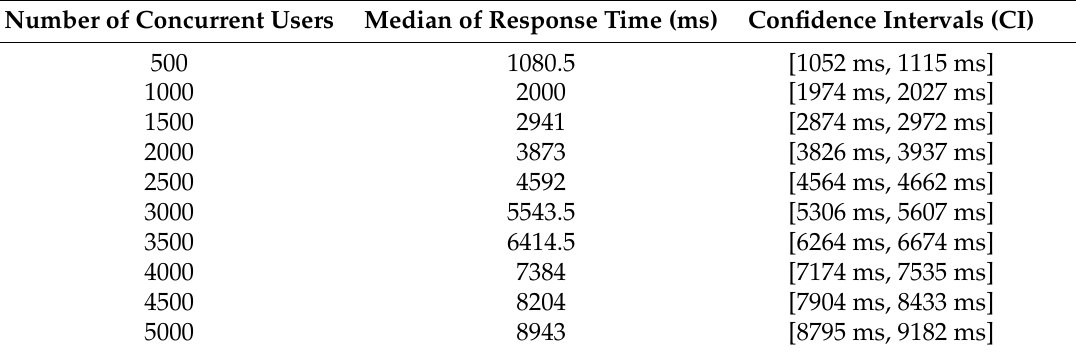
Table 3. Median of response times and confidence intervals (CI) in milliseconds (ms) for each number of simulated concurrent